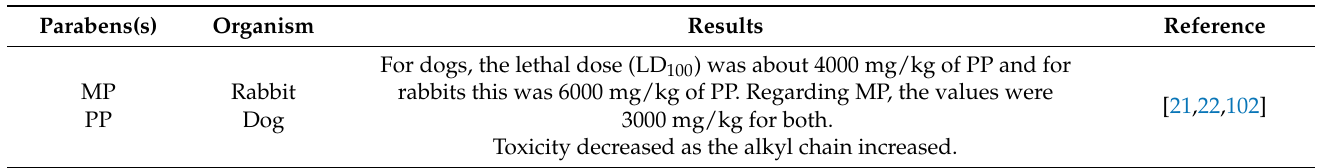
Table 3. Toxicological studies of parabens in different